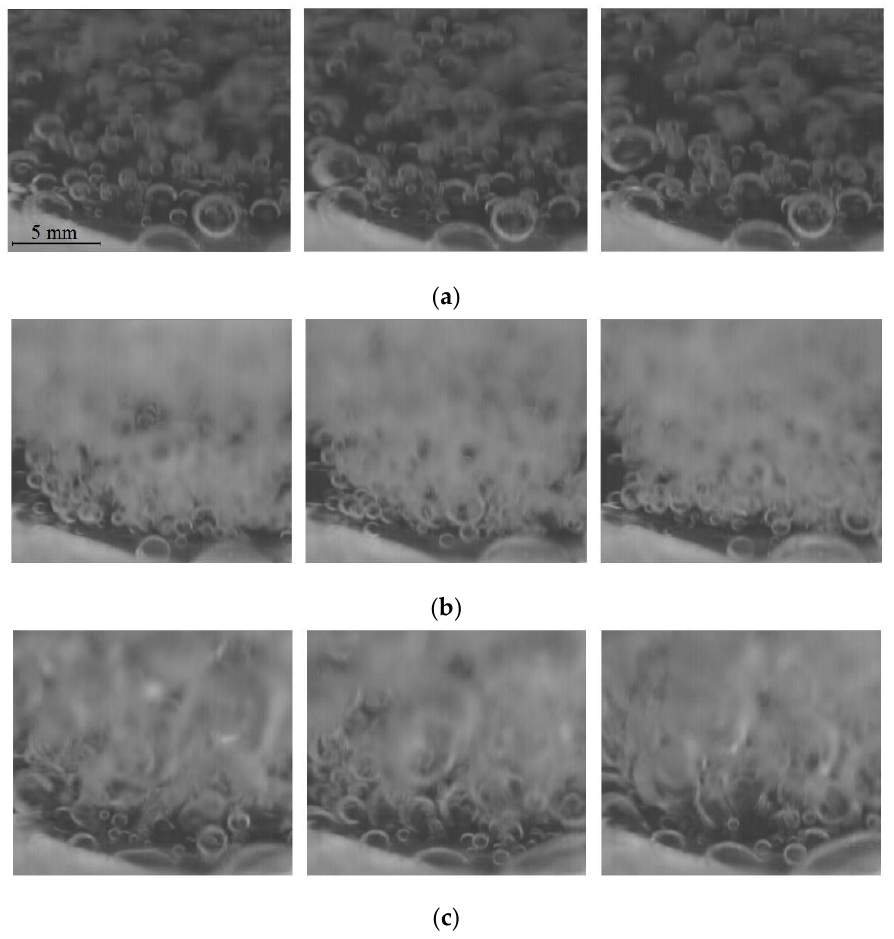
Figure 17. Boiling performance of a sample with a 0.4 mm groove depth and 1.5 mm groove width at a ( a ) heat flux of 20.7 kW/m 2 ; ( b ) heat flux of 45.1 kW/m 2 ; and ( c ) heat flux of 88.2 kW/m 2 .